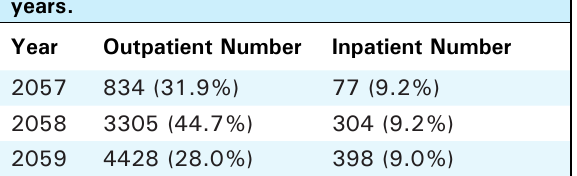
Table 3. Utilization of Services department